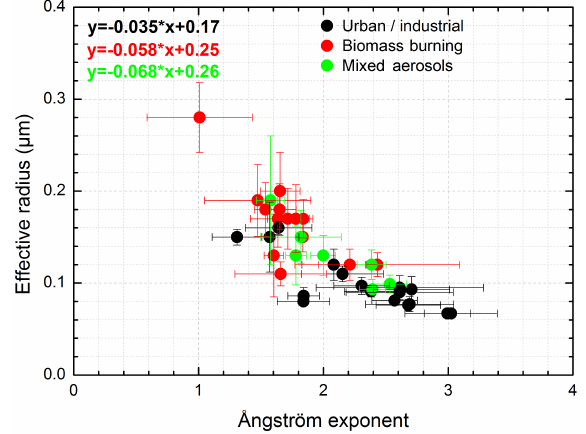
Figure 8. Effective radius vs. Ångström exponent for the three aerosol types investigated in our